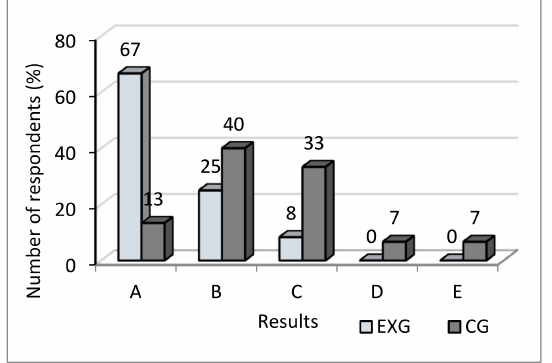
Figure 4. Post-test results in